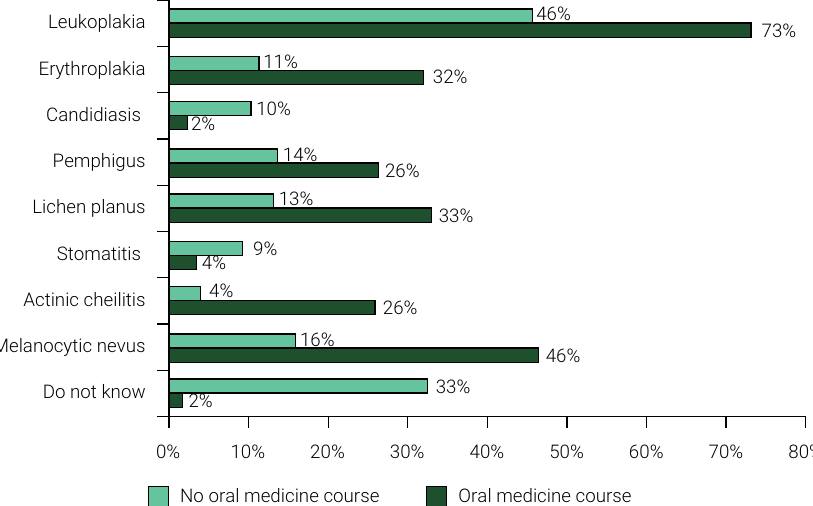
Figure 2. Percentage of students who correctly identified potentially malignant lesions, according to whether they had completed the oral medicine course.